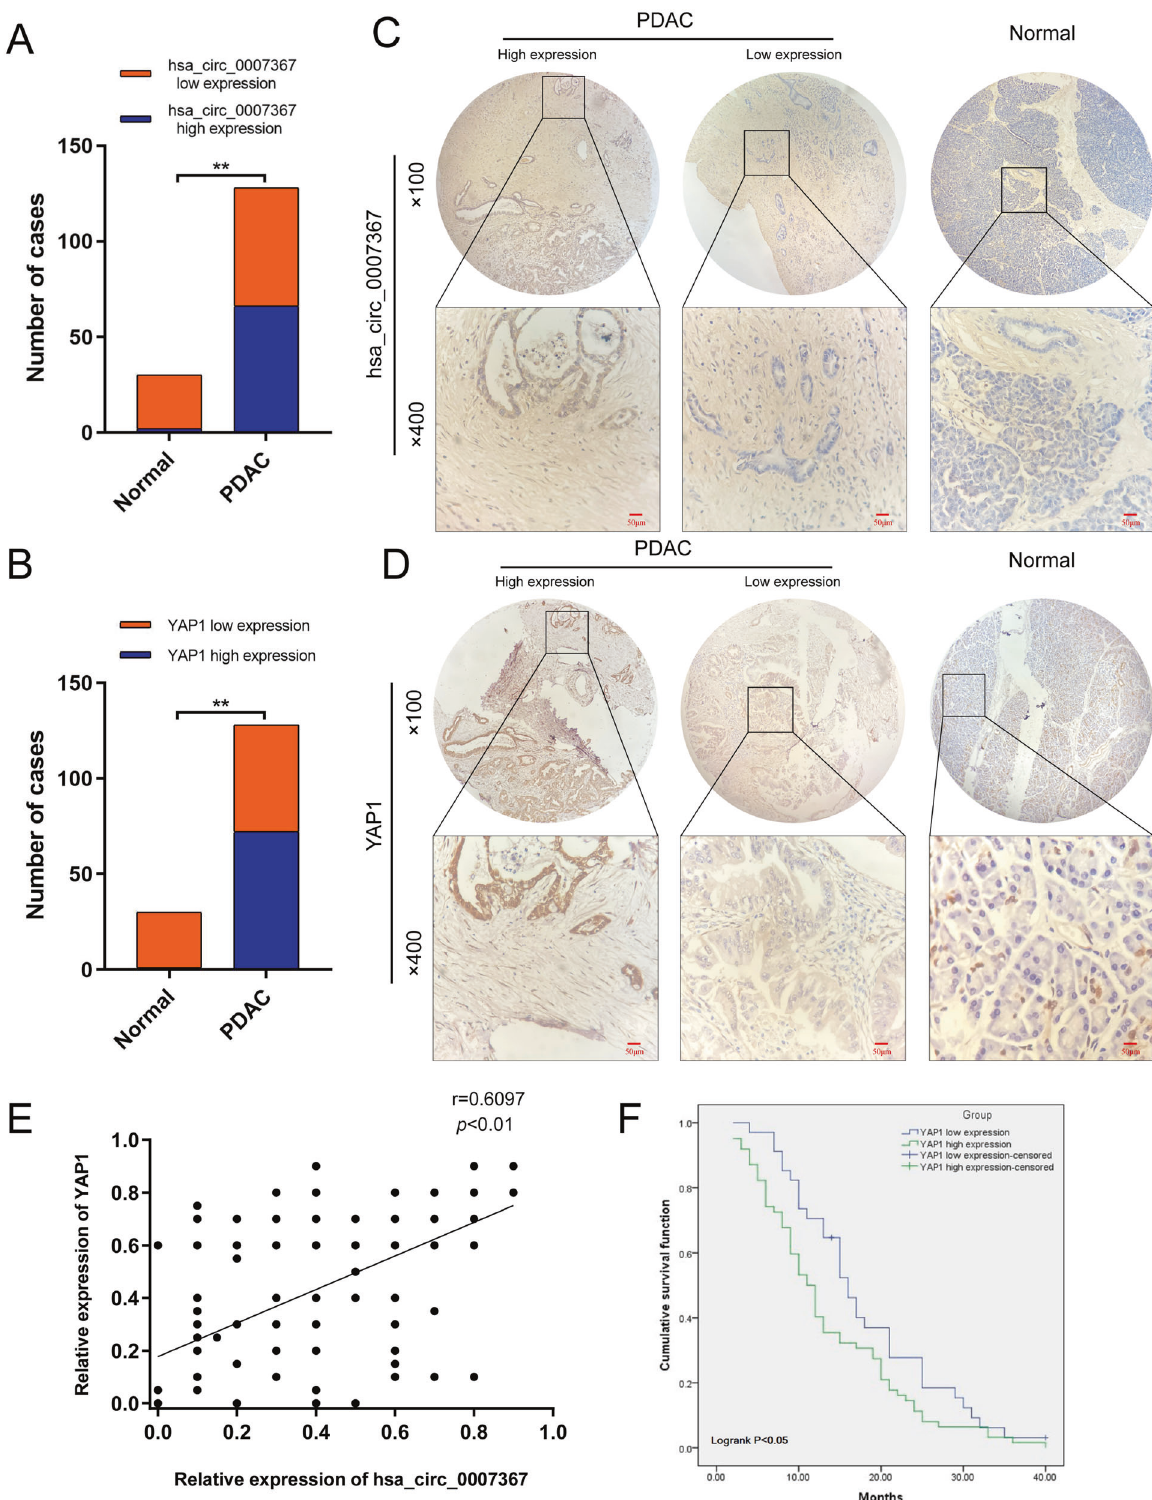
Fig. 8 Upregulated hsa_circ_0007367 related with poor prognosis of PDAC patients. A , B The numbers of hsa_circ_0007367 ( A ) and YAP1 B expression in TMAs. C , D Representative images showed the expression of hsa_circ_0007367 detected by ISH ( C ) and YAP1 detected by IHC ( D ) in TMAs. E The correlation between hsa_circ_0007367 and YAP1 expression in TMAs. F Kaplan – Meier survival curve for the overall survival of PDAC patients according to the relative expression of YAP1 in TMAs.